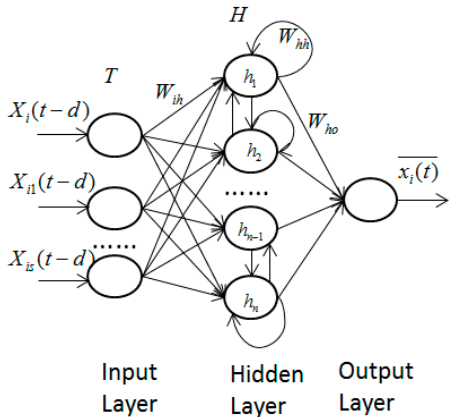
Figure 1. Water quality prediction model based on LSTM.